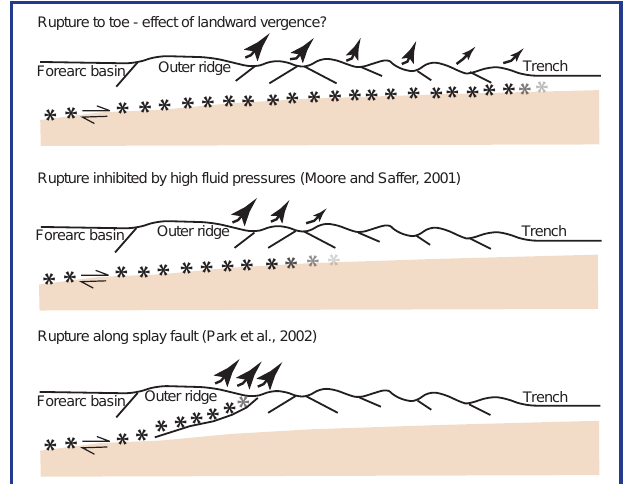
Figure 7. Alternative models for forearc fault architecture that accommodated rupture during the great Sumatra earthquake, and implications for tsunami generation. Figure courtesy of S. Gulick, N. Bangs, and J.